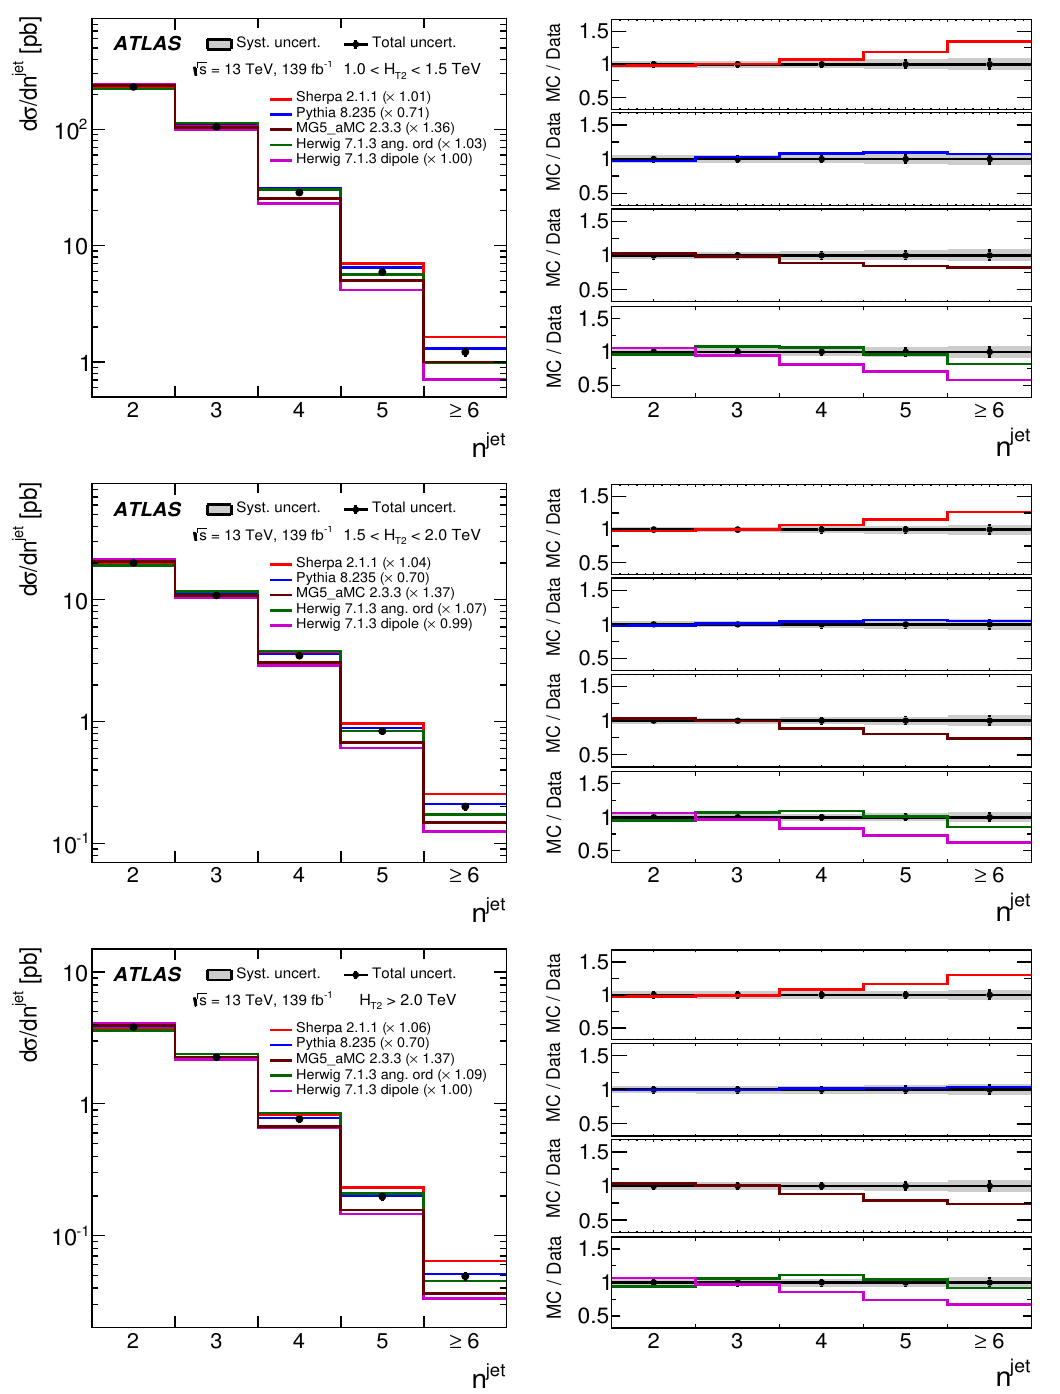
Figure 4 . Fiducial cross section as a function of jet multiplicity. The MC predictions are normalised to the measured integrated cross section for n jet ≥ 2 in each H T2 bin using the factors indicated in parentheses. The right panels show the ratios of the MC distributions to the data distributions. The error bars show the total uncertainty (statistical and systematic added in quadrature) and the grey bands in the right panels show the systematic